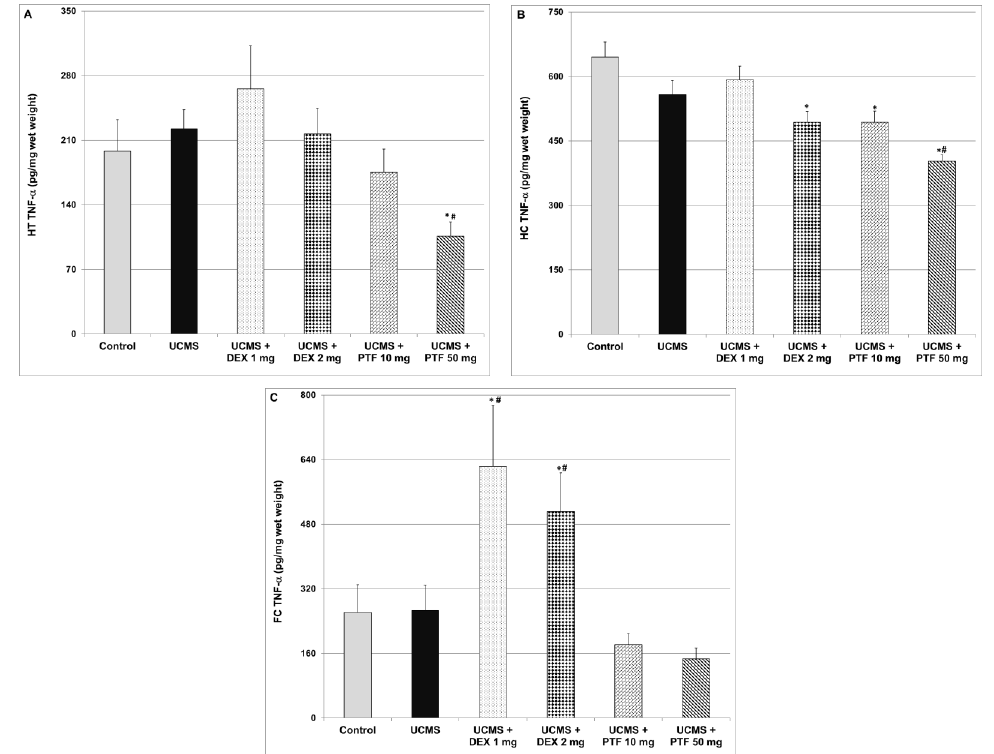
Figure 4. Effects of DEX and PTF on TNF- α levels in brains of UCMS rats. ( A ) Hypothalamus (HT), ( B ) hippocampus (HC) and ( C ) frontal cortex (FC). Values are means ± SEM of 11–12 rats in each group. ( A ) One-way ANOVA test: F = 3.19, p = 0.012; t -test: * p < 0.05 vs. control, # p < 0.05 vs. UCMS. ( B ) One-way ANOVA test: F = 11.82, p = 0.0001; t -test: * p < 0.05 vs. control, # p < 0.05 vs. UCMS. ( C ) One-way ANOVA test: F = 6.09, p = 0.0004; t -test: * p < 0.05 vs. control, # p < 0.05 vs.